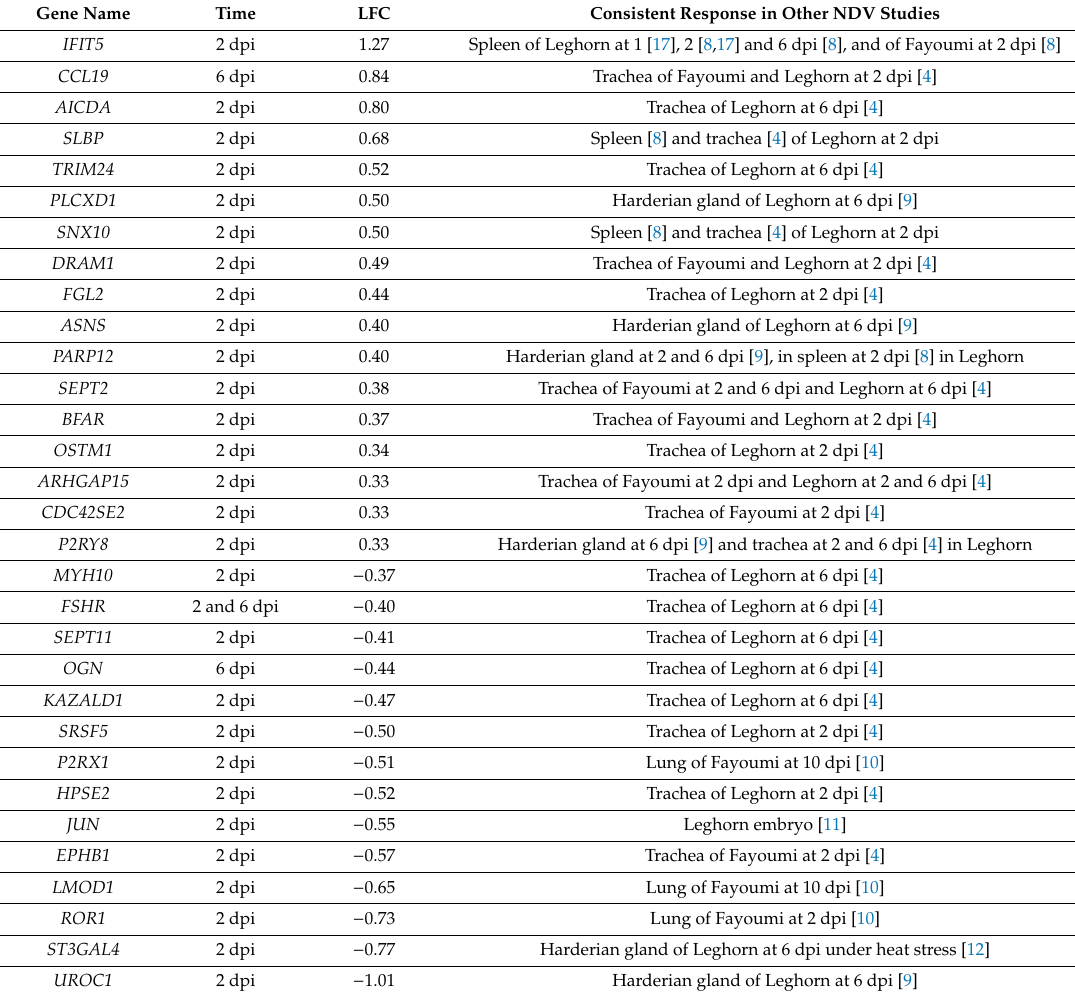
Table 4. DEGs with consistent responses in expression to NDV in the current and previous